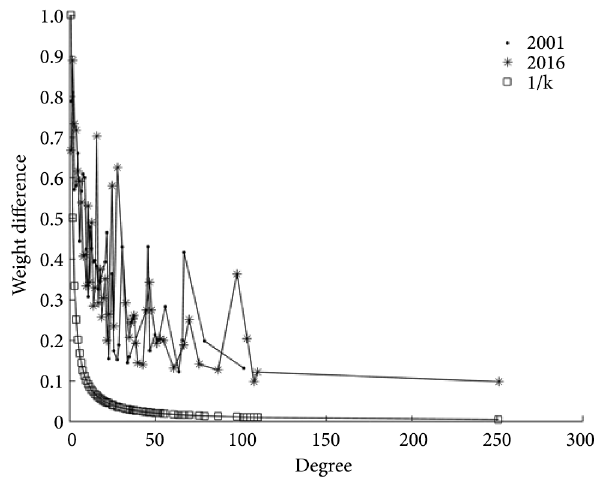
Figure 11. Evolution of weight difference coefficients in 2001 and